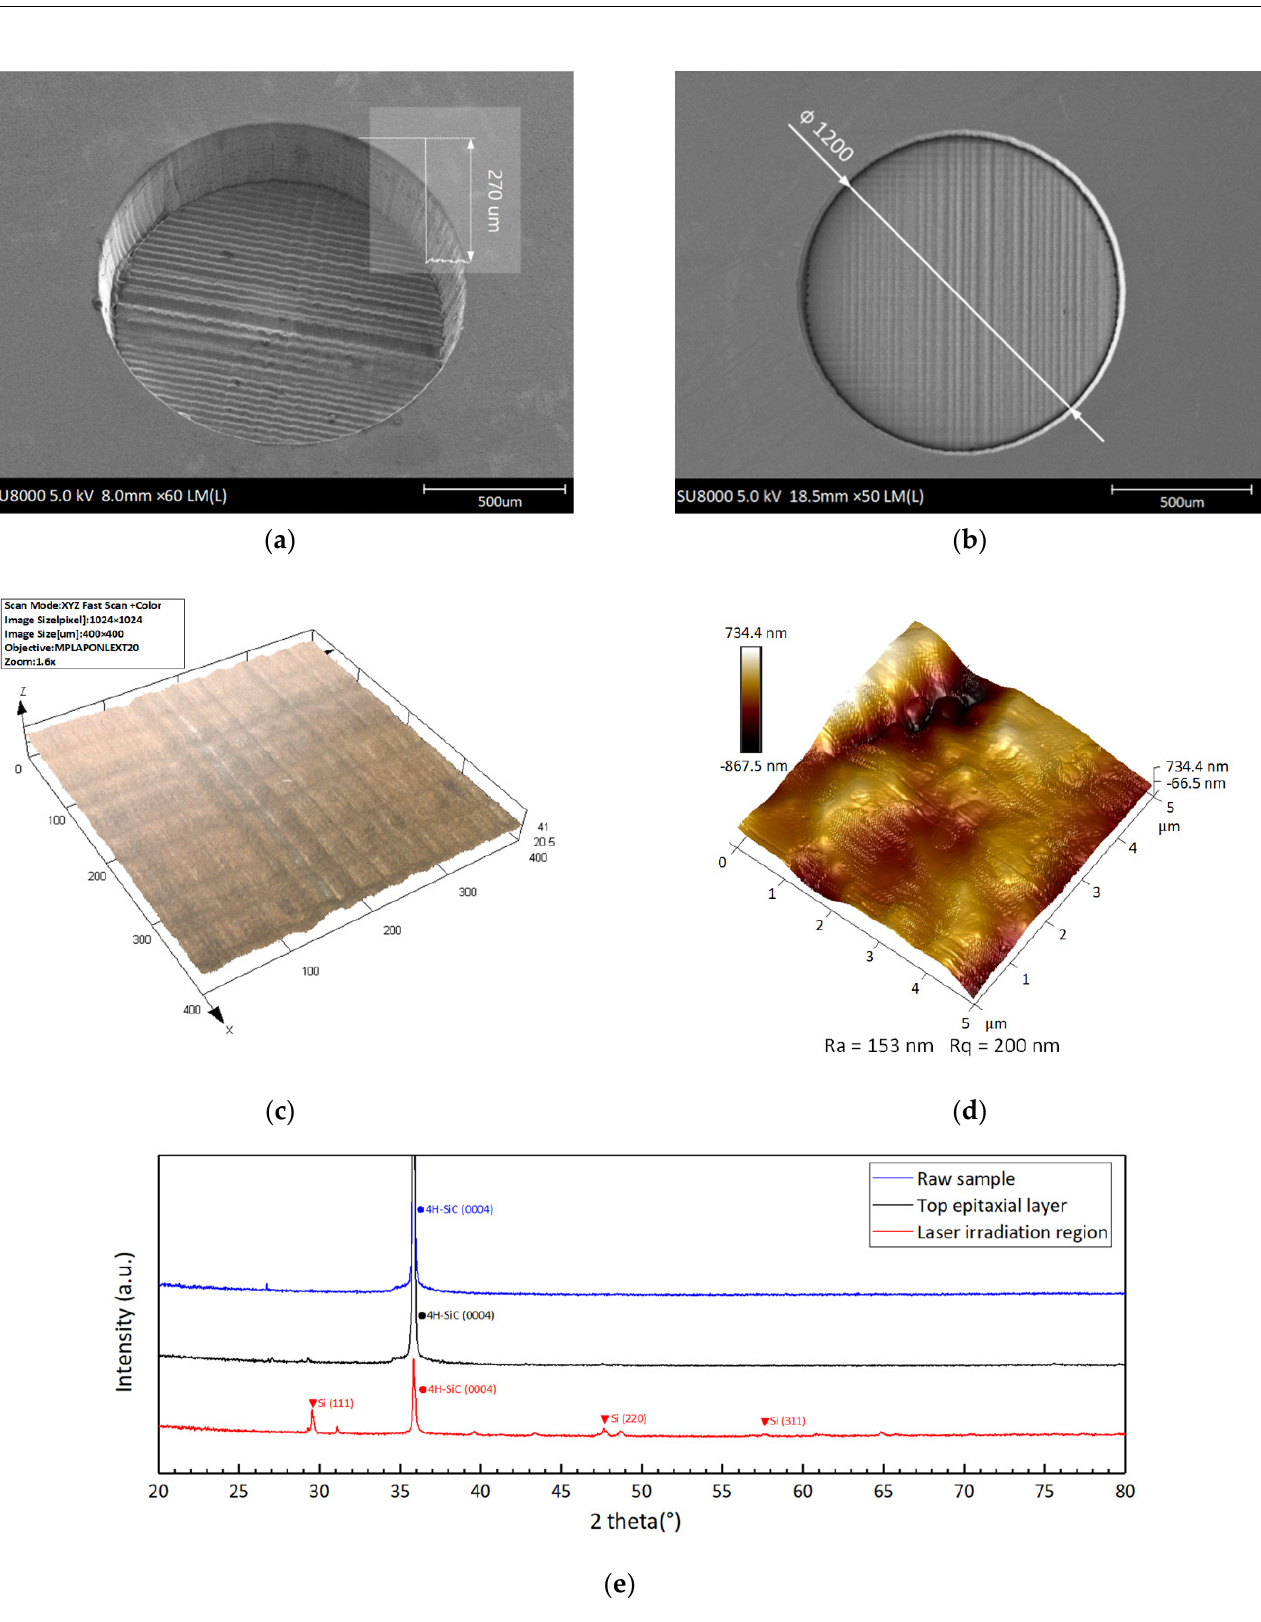
Figure 8. SEM images of micro blind hole in oblique view ( a ) and top view ( b ). ( c ) Laser scanning confocal microscopy (LSCM) image of the bottom of the micro blind hole. ( d ) Atomic force microscope (AFM) 3D image of the surface of laser-irradiated region. ( e ) XRD diffractograms of different 4H-SiC samples.